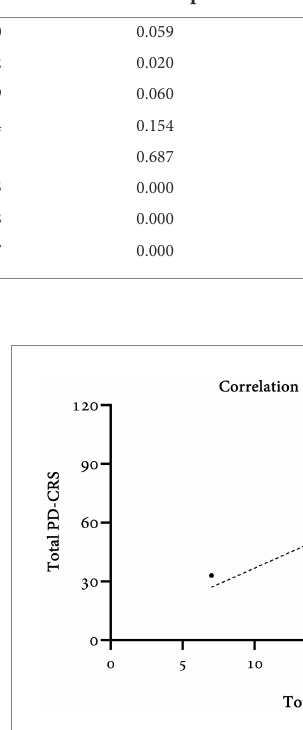
FIGURE 3 Correlation between MoCA and PD-CRS total